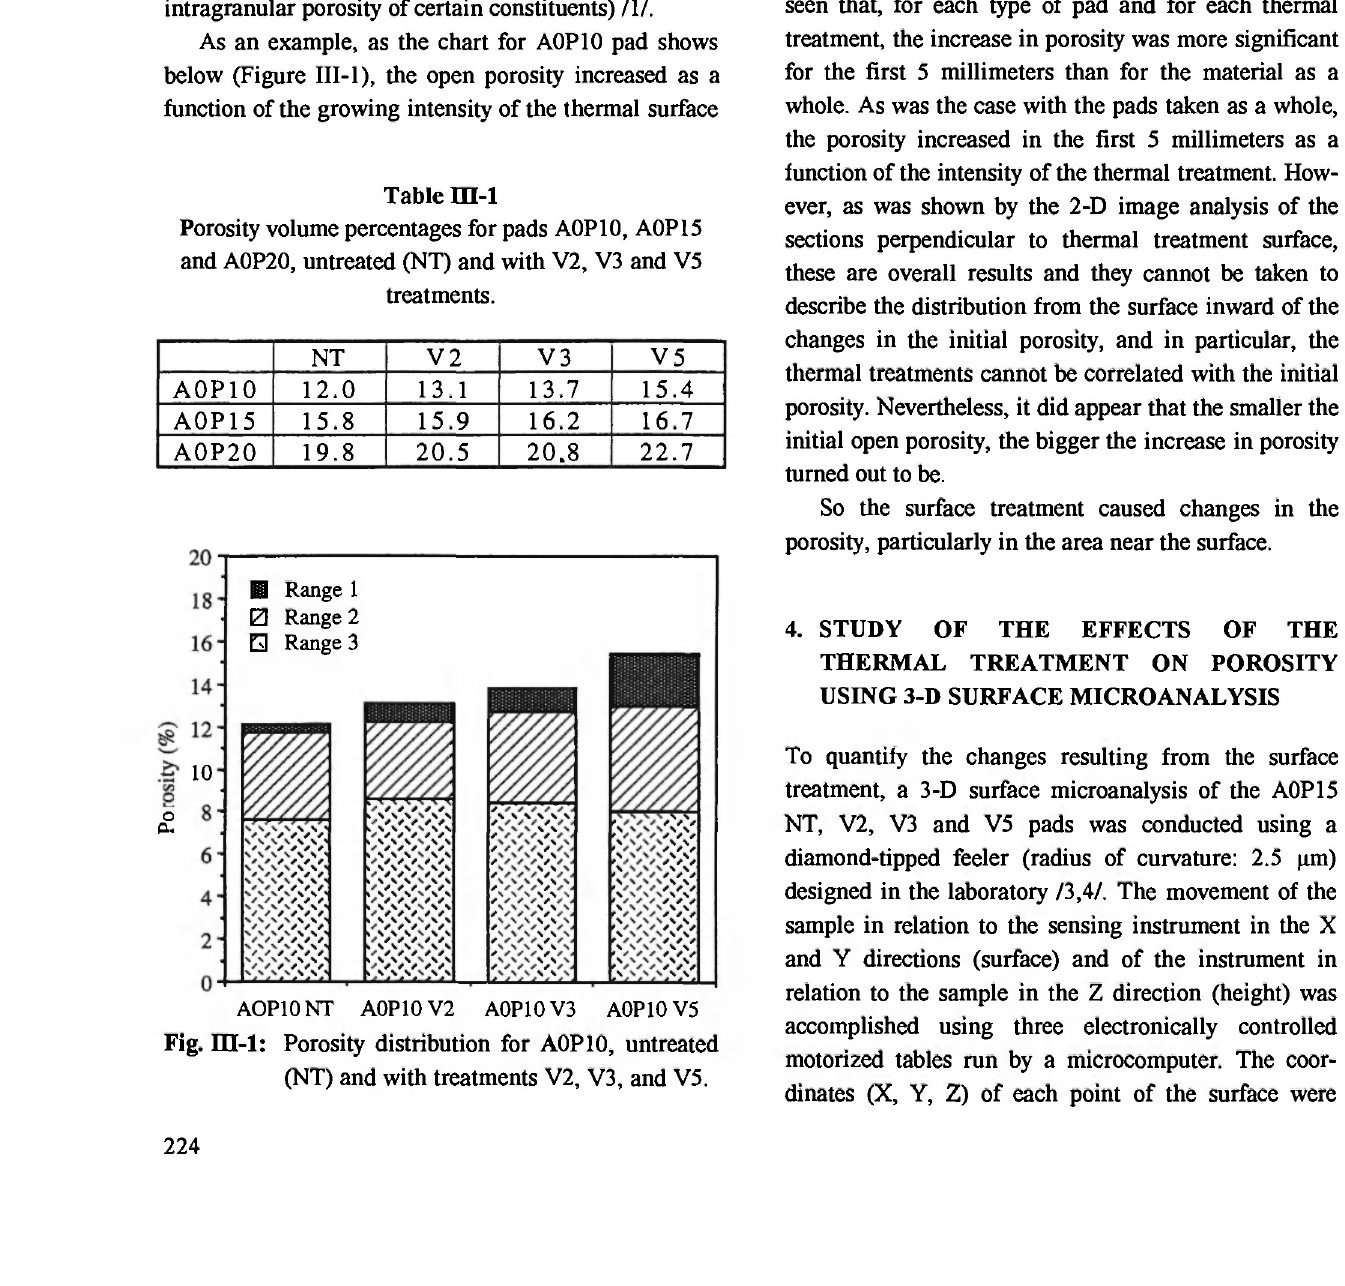
Fig. m-1: Porosity distribution for A0P10, untreated (NT) and with treatments V2, V3, and